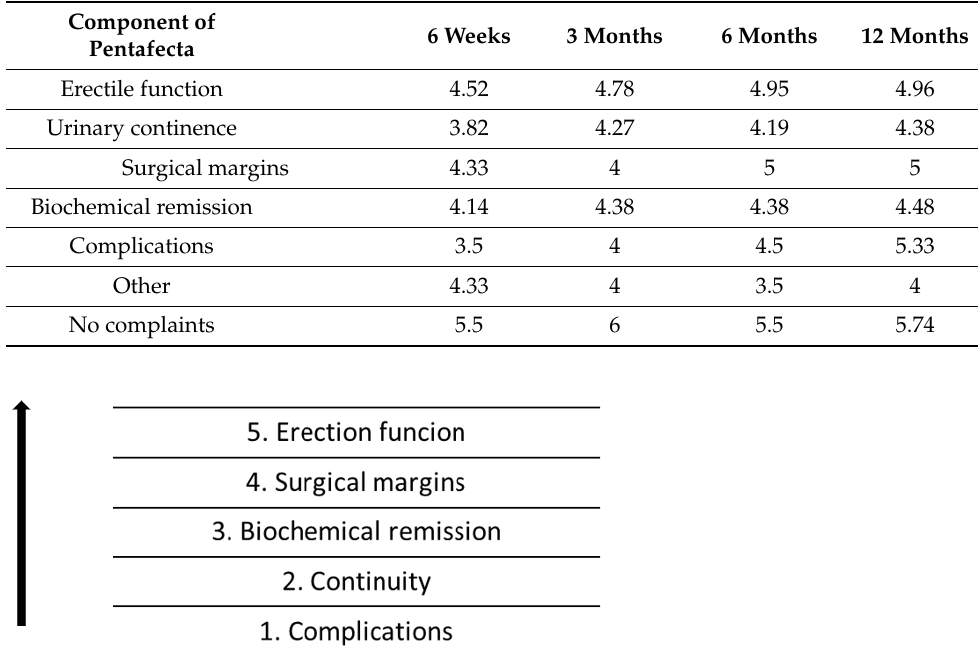
Table 4. Summary of the average declared quality of life in patients reporting the indicated ailment as dominant (scale of 1–6, Appendix A).